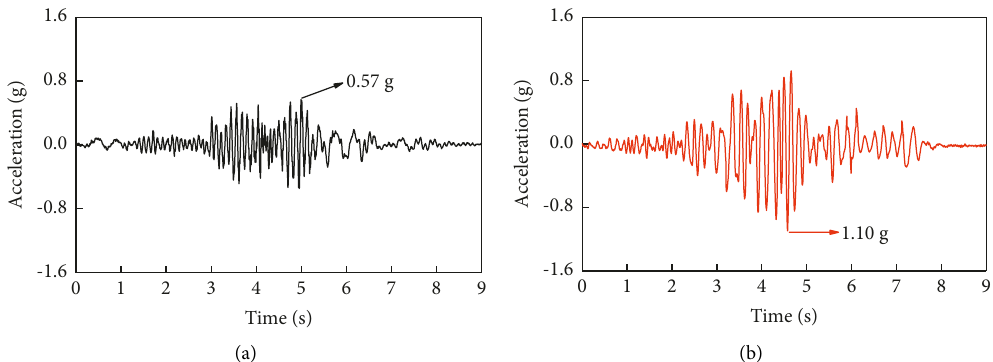
Figure 7: Acceleration time history at the top of specimen for (a) (x) direction and (b) (y) direction under 0.45g experimental earthquake excitation.